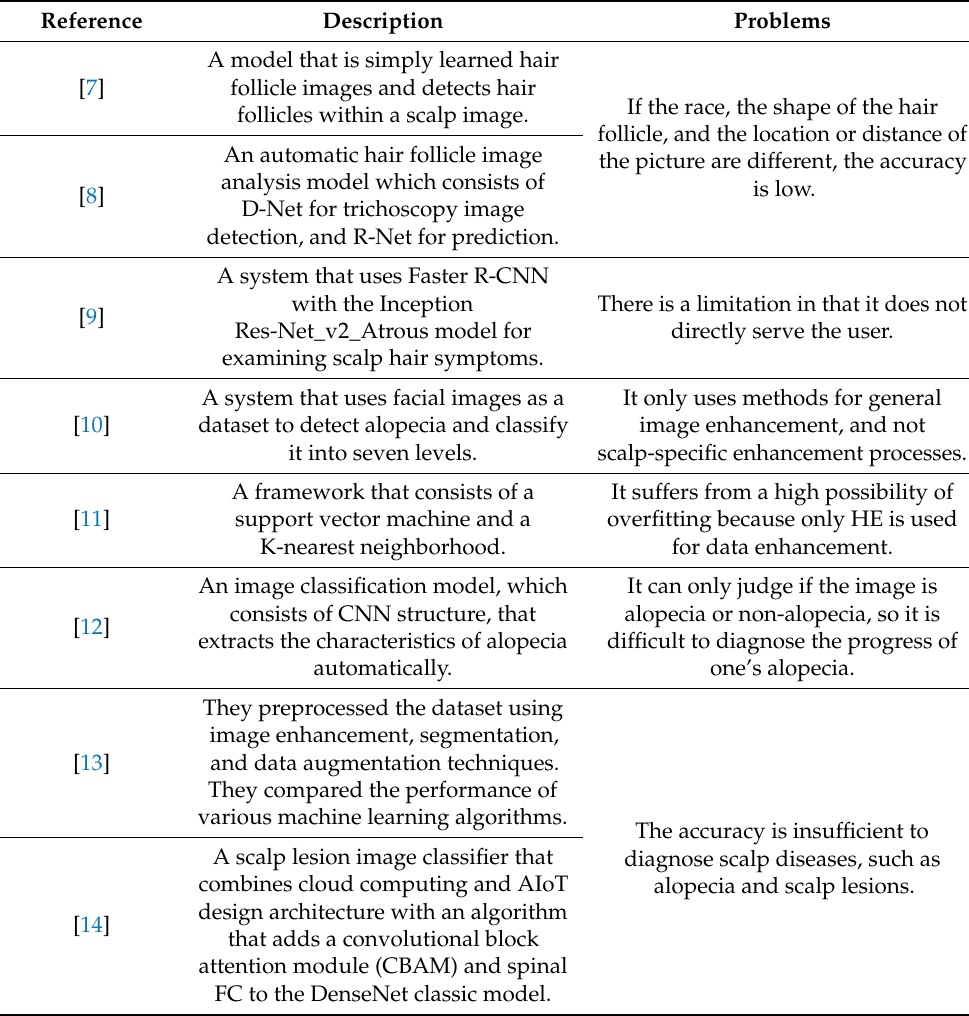
Table 2. Summary of the existing models for scalp